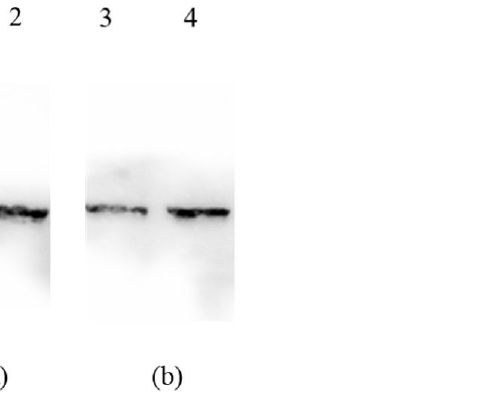
Figure 6. Detection of the purified M2e-NP and mM2e-NP proteins using ( a ) mouse anti-M2e and ( b ) mouse anti-NP antibodies in the western blotting. Lanes 1 & 3, mM2e-NP; 2 & 4, M2e-NP